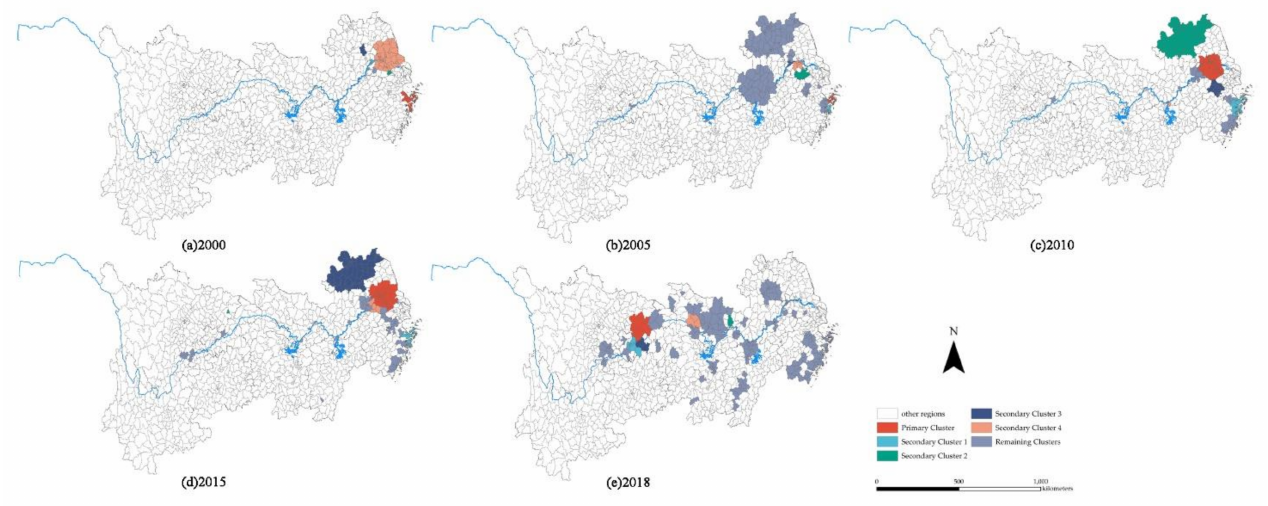
Figure 6. ( a – e ) annual spatial scanning